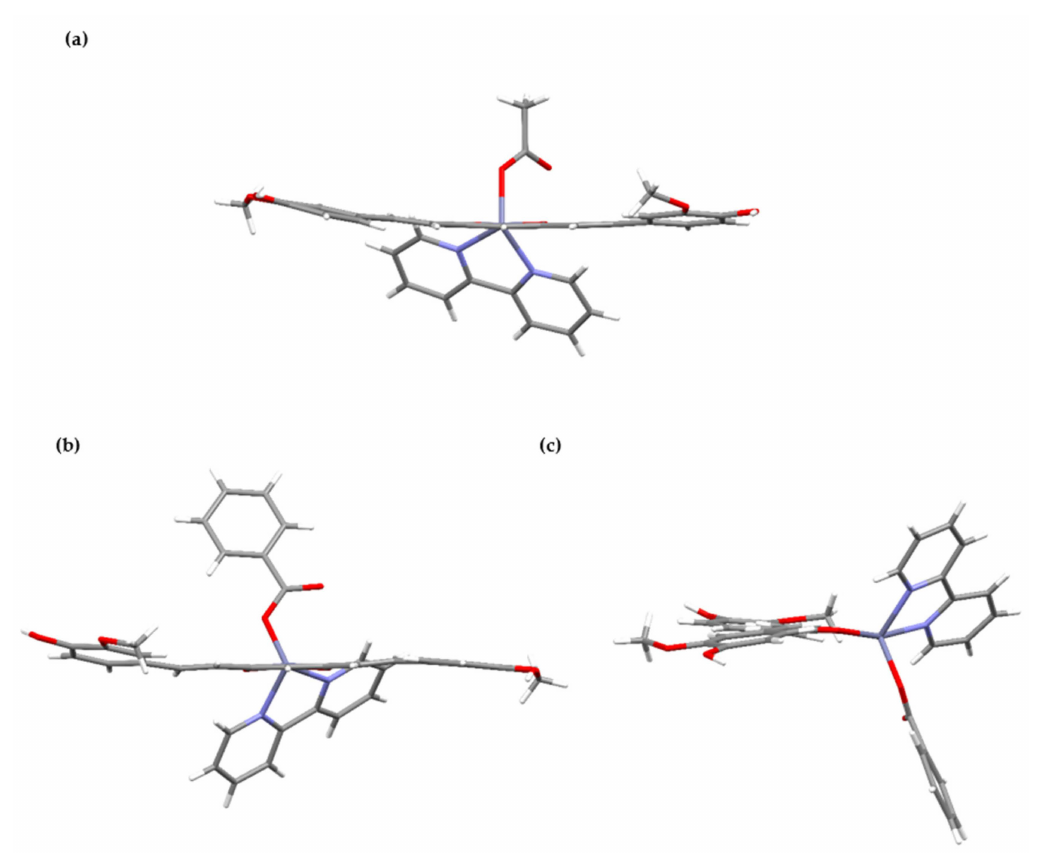
Figure 4. Projections of complex molecules [Zn(CH 3 COO)(cur)(bpy)]( 1) ( a ) and [Zn(PhCOO)(cur) (bpy)]( 2 ) ( b , c ). The top drawing shows a slight curvature of the cur − ligand in 1 , whereas a twisted orientation of the aromatic planes in 2 is shown by the bottom